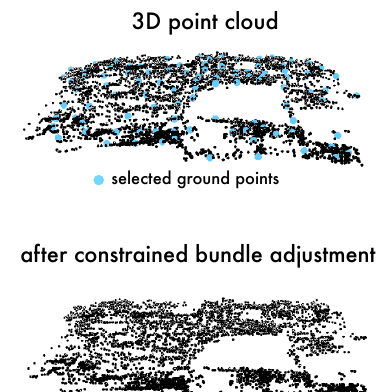
Figure 6. Top views of the doming effect on three datasets. The elevation values of the points is color-coded.